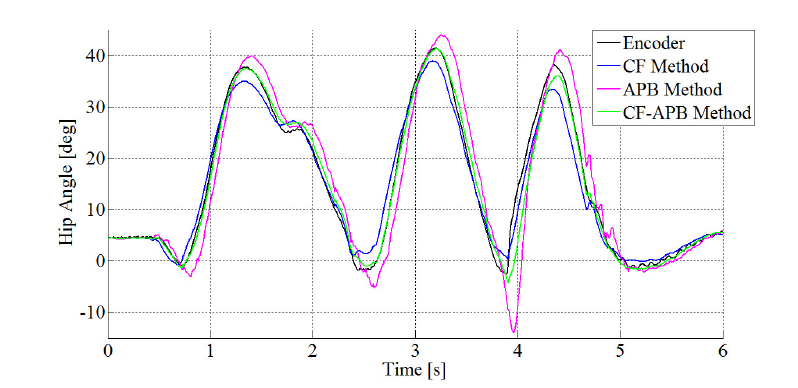
( a ) Comparison between acceleration propagation-based method (APB), complementary filter (CF) and CF-APB performances vs. encoder measurement for hip angle estimation. ( b ) Comparison between APB, CF and CF-APB performances vs. encoder measurement for knee angle